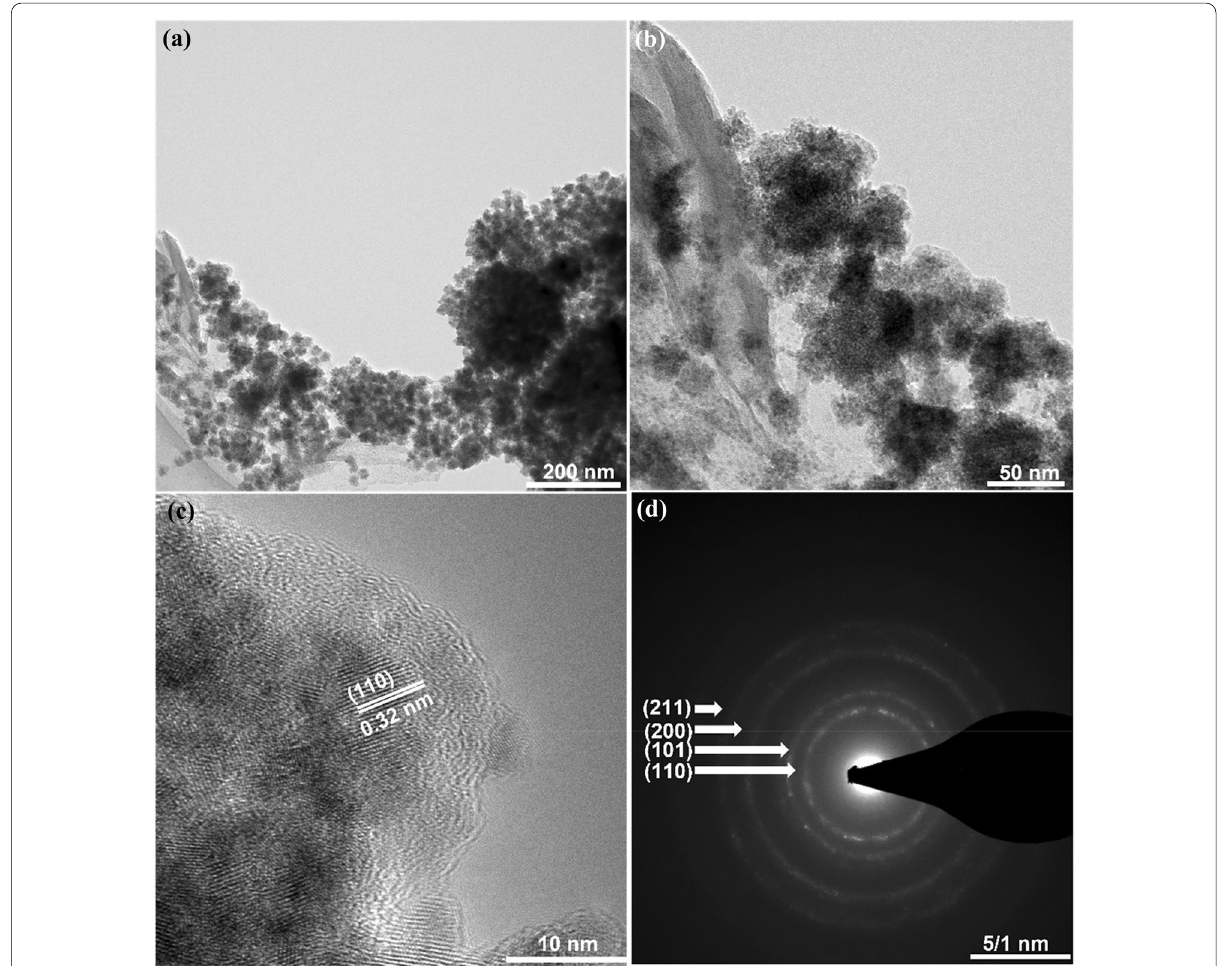
Fig. 3 Electron microscopy images of the as‑prepared materials in transmission mode. a , b TEM images of the reduced graphene